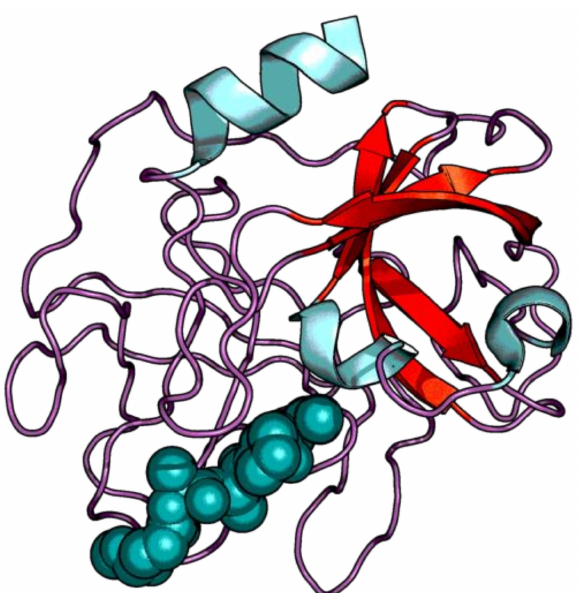
Figure 9. Structure of human neutrophil elastase in complex with MSACK (PDB code: 1HNE) [104]. The inhibitor molecule is presented as